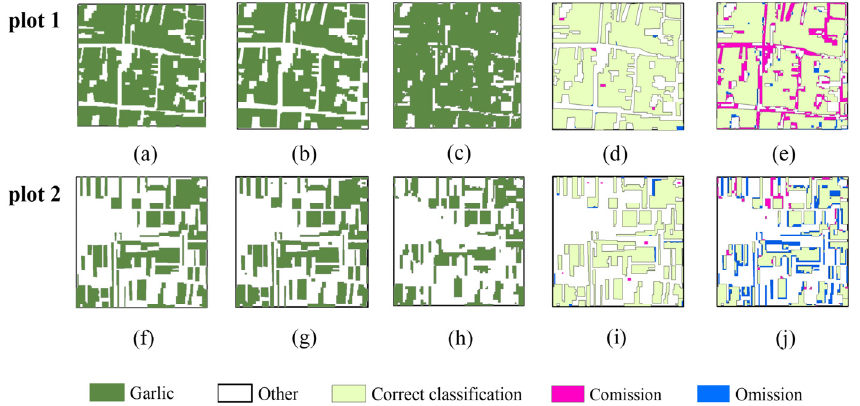
Figure 9. Results of accuracy validation based on two validation quadrats with an area of 1 km by 1 km. ( a , f ) The ground truth quadrats. ( b , g ) The extraction results in Scheme VI. ( c , h ) The garlic extraction results in Scheme I. ( d , i ) Accuracy validation results in Scheme VI. ( e , j ) Accuracy validation results in Scheme I.